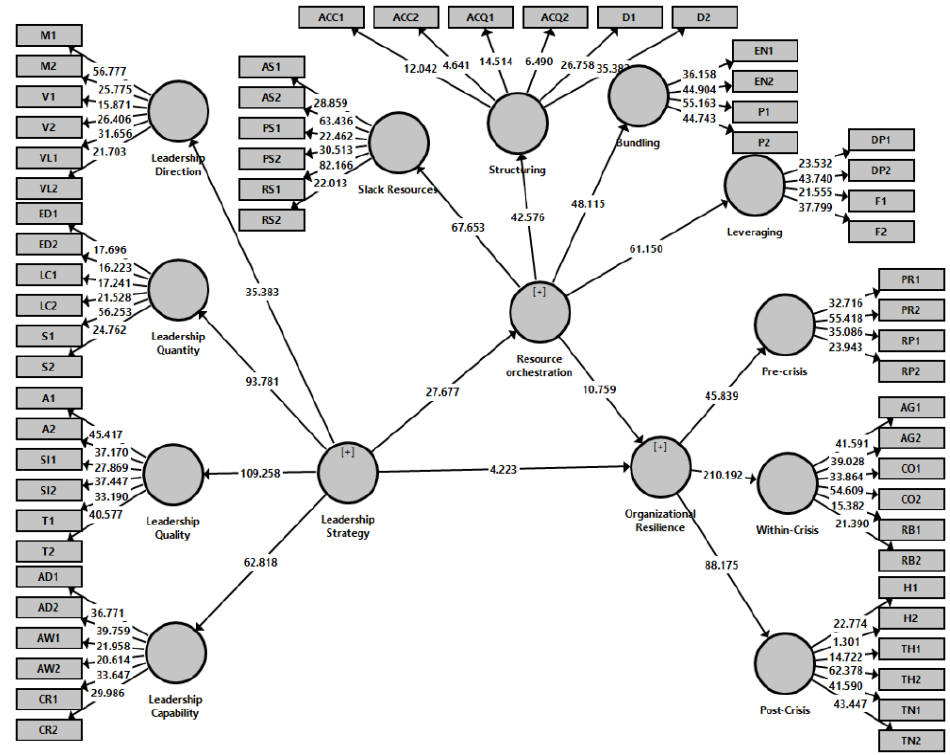
Figure 11: Mode t-Statistics of Aggregate Resource